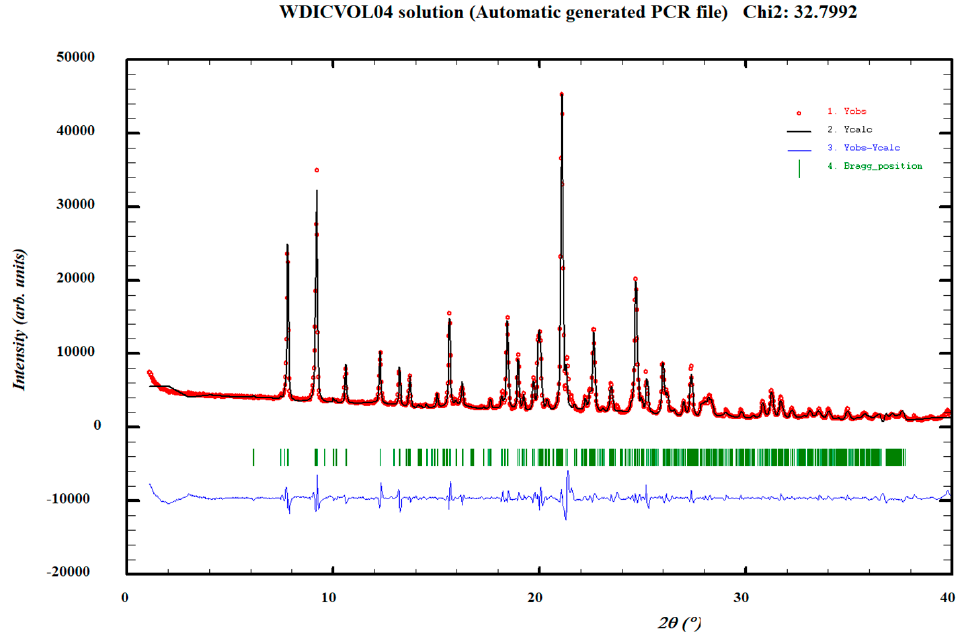
Figure 2. Pattern matching refinement of the Norfloxacin–resorcinol cocrystal. Agreement factors: R wp : 9.5%; R exp : 1.7% (Chi 2 = 33). Experimental XRPD profile (red marks), calculated XRPD profile (black solid line) and the difference between them (blue, line). Tick marks correspond to peak positions (|, in green).